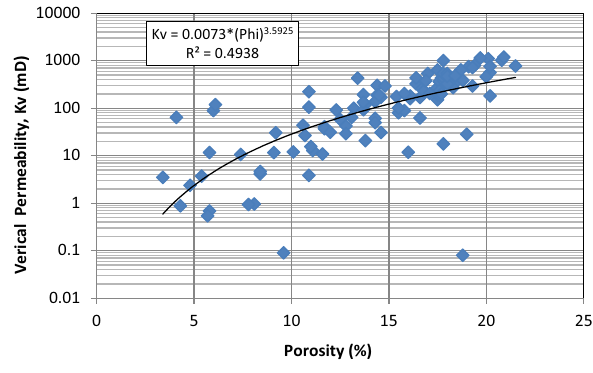
Kv = 0.0073*(Phi) 3.5925 R² = 0.4938